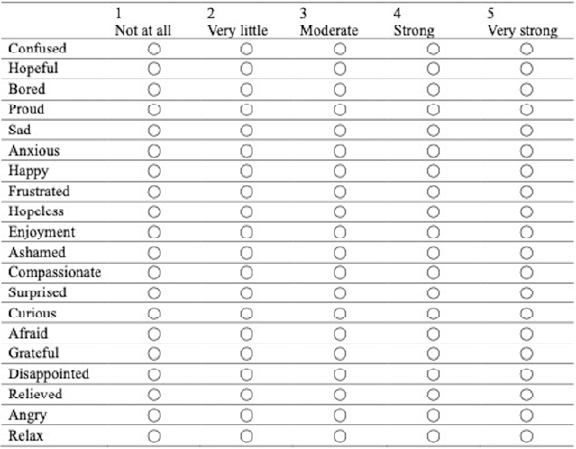
Figure 1. Sample of the Medical Emotion Scale.